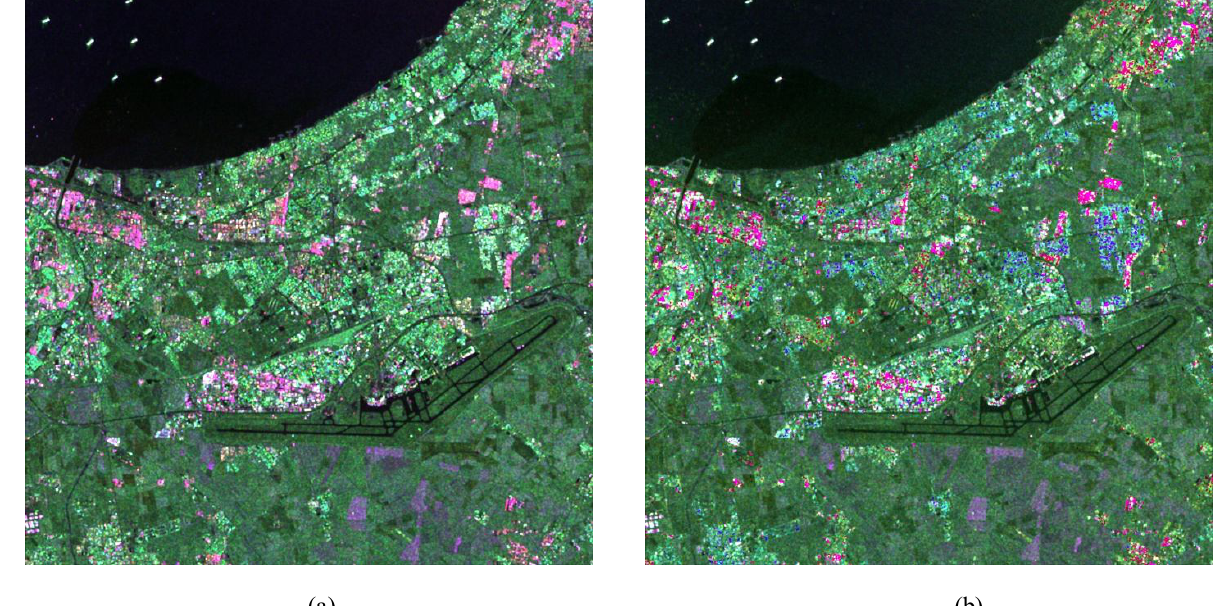
Figure 4: Full (a) RGB versus compact polarimetric (b) RGB color composit images, (Red:H, Green:X, Blue:V)